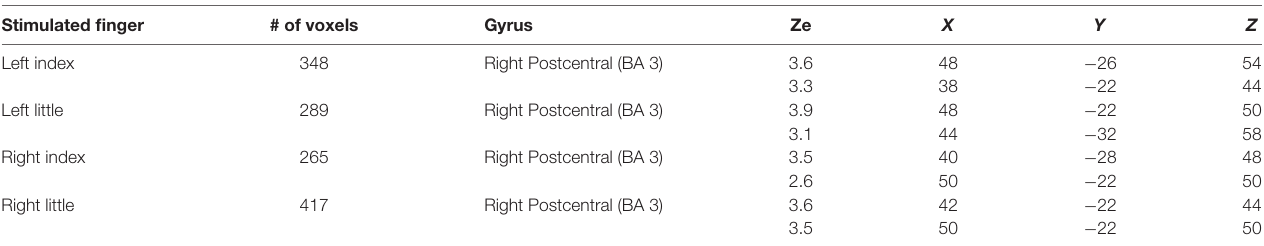
TABLE 1 | Main effect of injury in contralesional